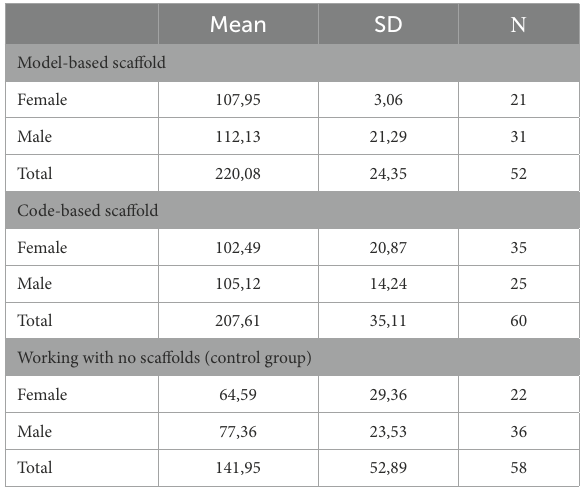
TABLE 7 Descriptive statistics of children’s computational thinking in Phase 2 for each scaffold and